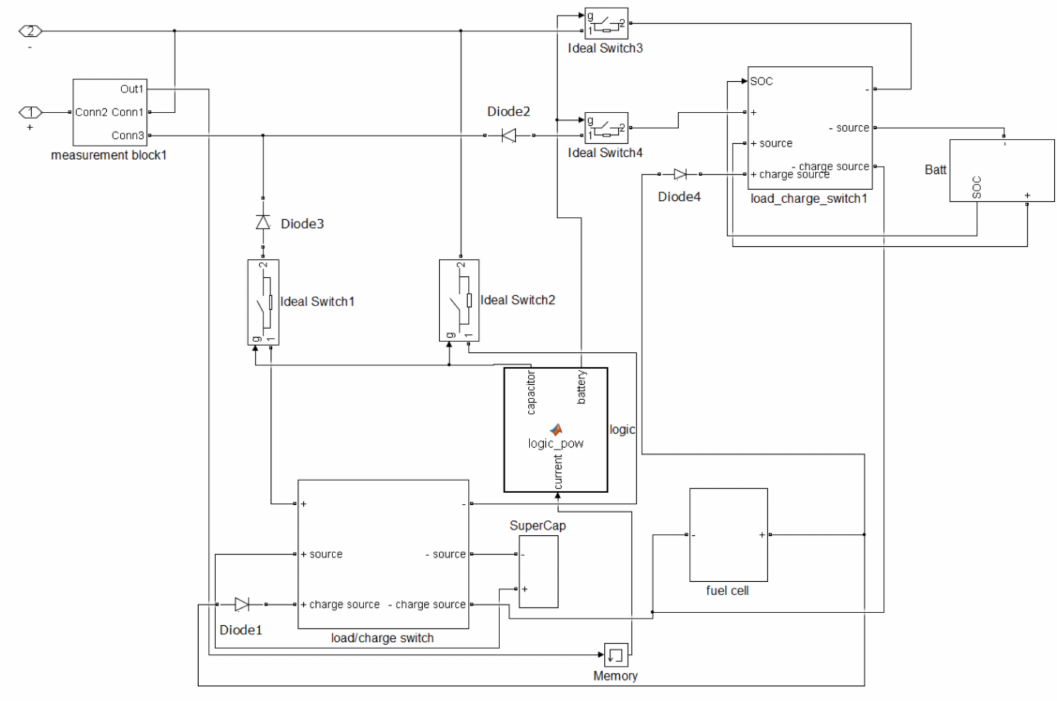
Figure 5. Hybrid power system first